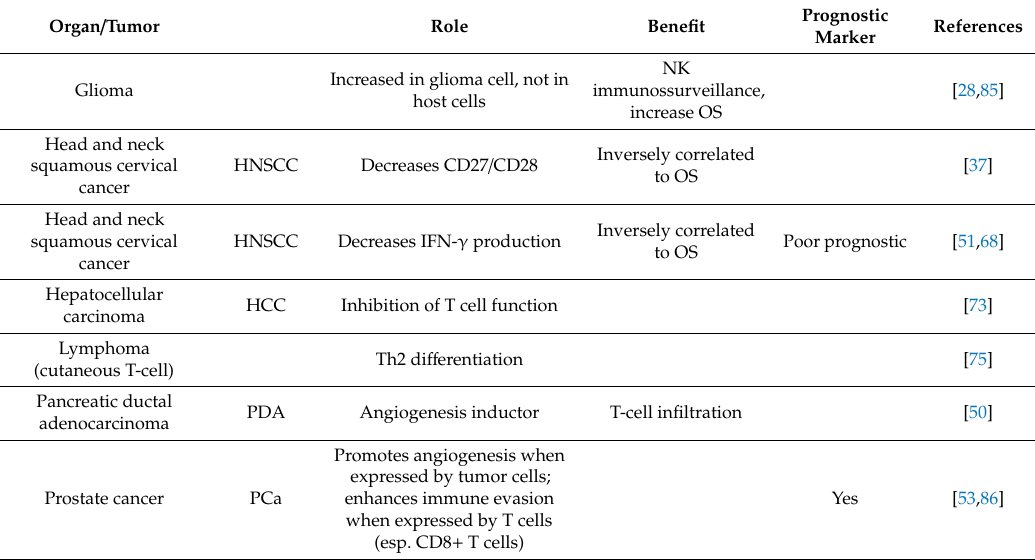
Table 2. Galectin-1 on immune cells in the tumor microenvironment. OS, overall survival.